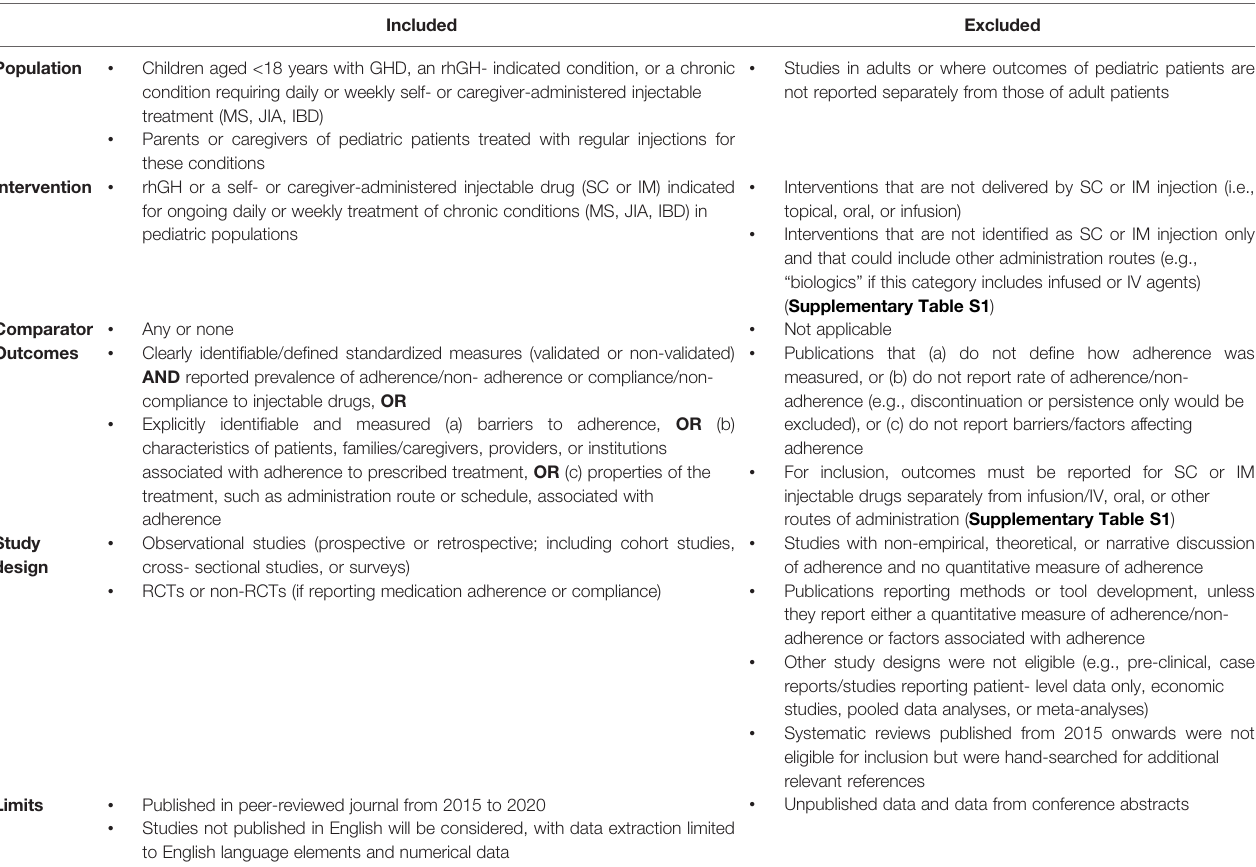
TABLE 1 | Summary of eligibility criteria.